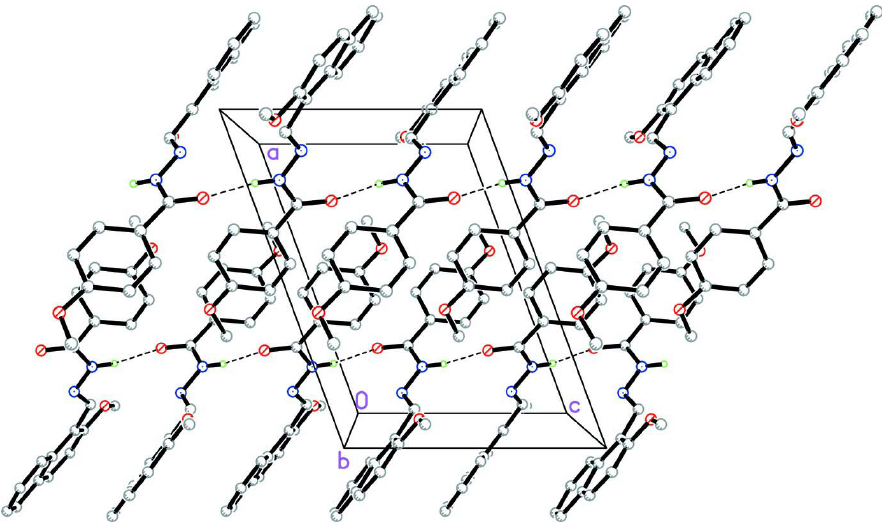
The molecular structure of (I), with atom labels and 30% probability displacement ellipsoids for non-H atoms.